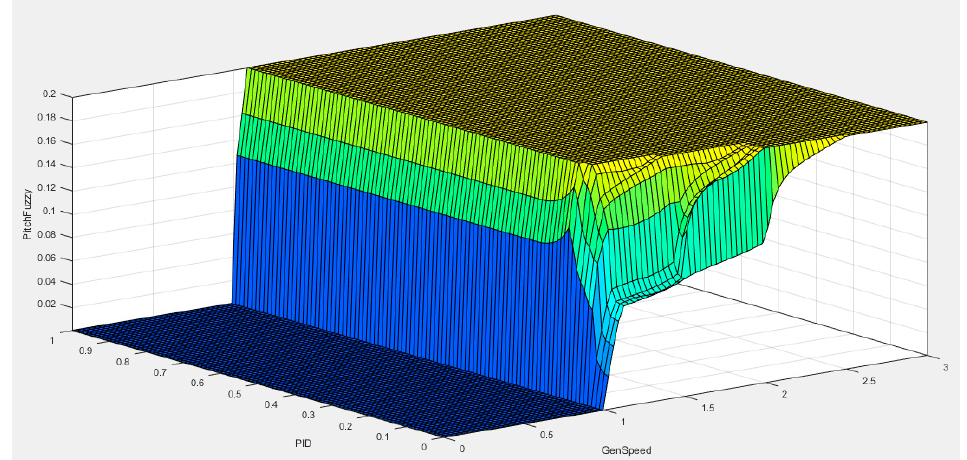
functions to produce the output. The general form representation is due to using a big mesh with low precision.